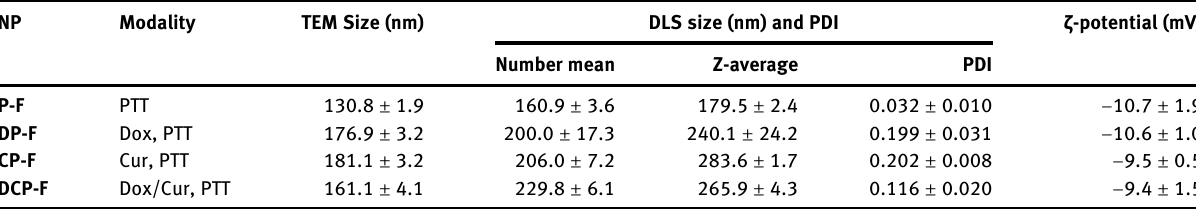
Figure 1: Physicochemical characteristics of DCP-F NPs. (a) Representative TEM images of DCP-F NPs; (b) hydrodynamic size distribution and (c) ζ -potential of typical NPs; (d) fl uorescence spectra of typical NPs upon excitation at 433 nm (left) and 490 nm (right), respectively; (e) temperature pro fi les (f) and thermal images of DCP-F suspensions upon 808 nm laser irradiation at 1 W/cm 2 within 8 min. Table  : Basic physicochemical properties of NPs prepared in this